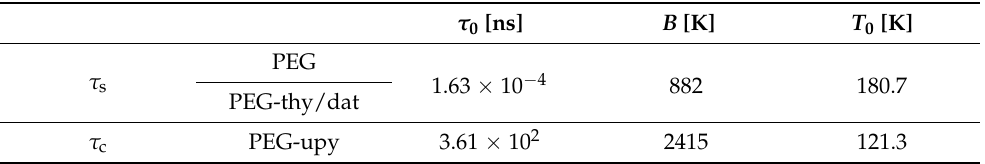
Table 7. Fitting parameters of the temperature dependence of the segmental relaxation time, τ s for PEG polymer and PEG-thy/dat and the longest relaxation time τ c for PEG-upy using Equation (7).